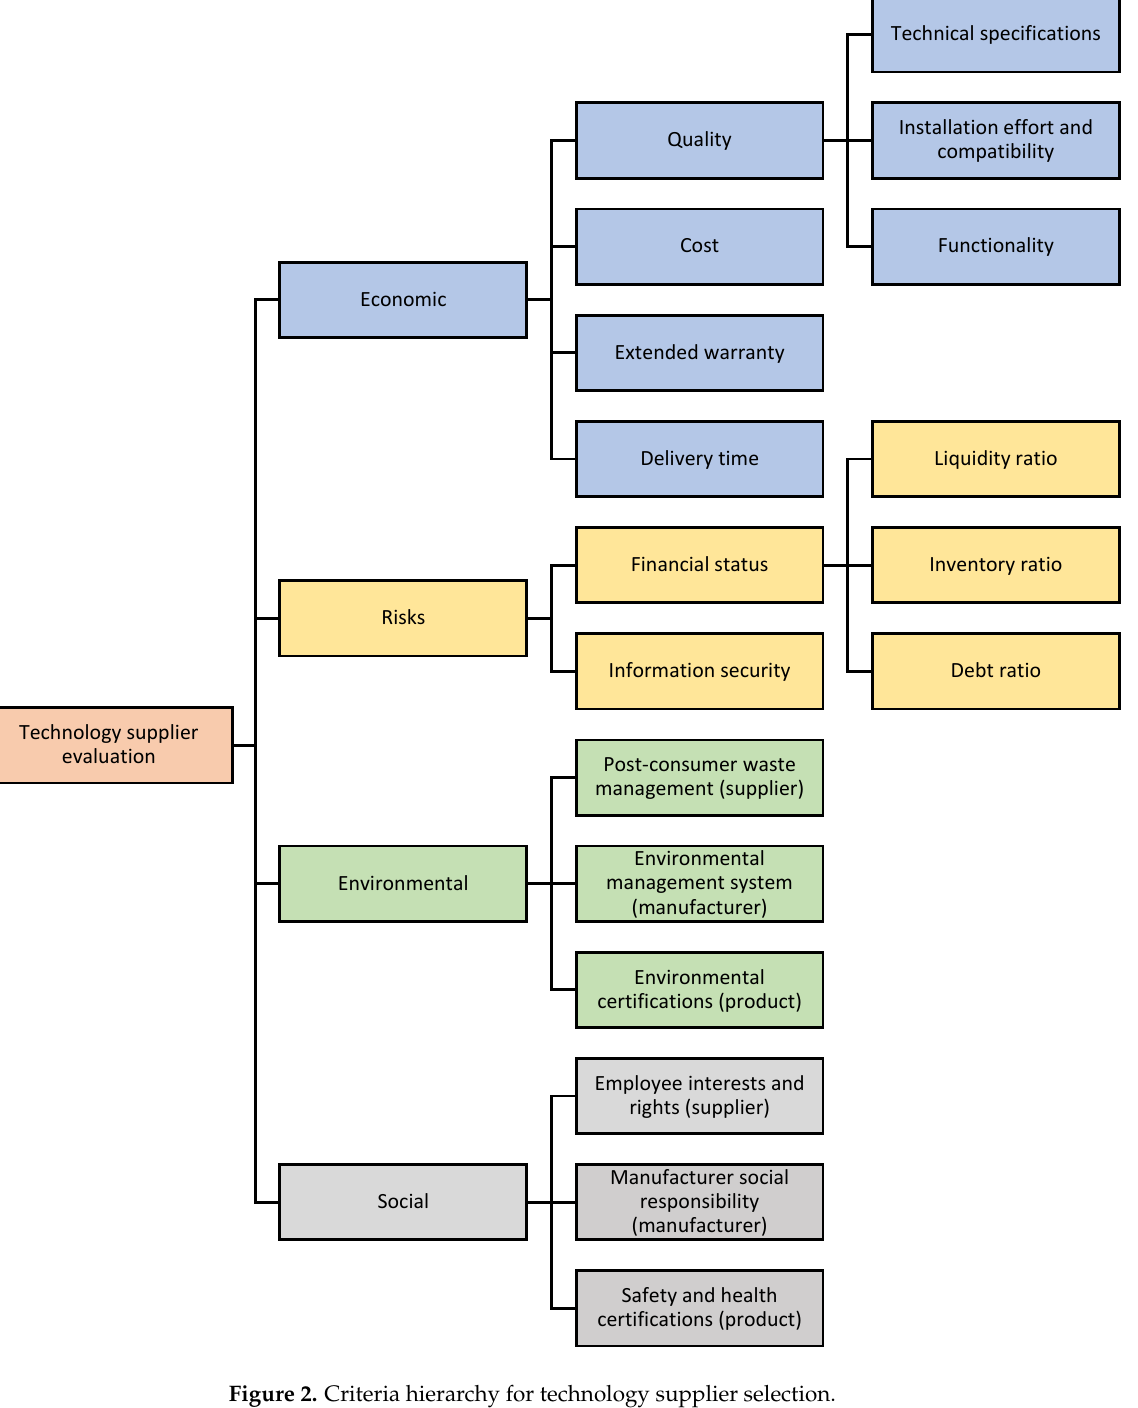
Figure 2. Criteria hierarchy for technology supplier selection.